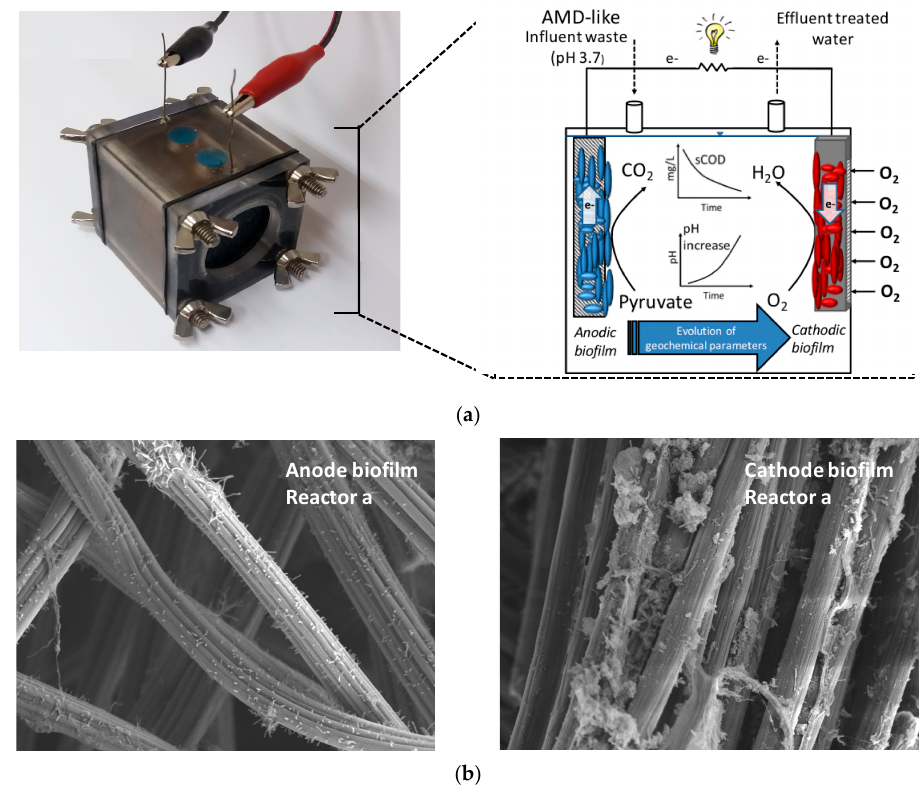
Figure 1. ( a ) Photograph of a single-chamber air-cathode microbial fuel cell (SC-MFC) and conceptual model used in the study; ( b ) SEM micrographs from surface of biofilm attached to the anode ( bottom left image ) and cathode ( bottom right image ) of the MFC reactor.